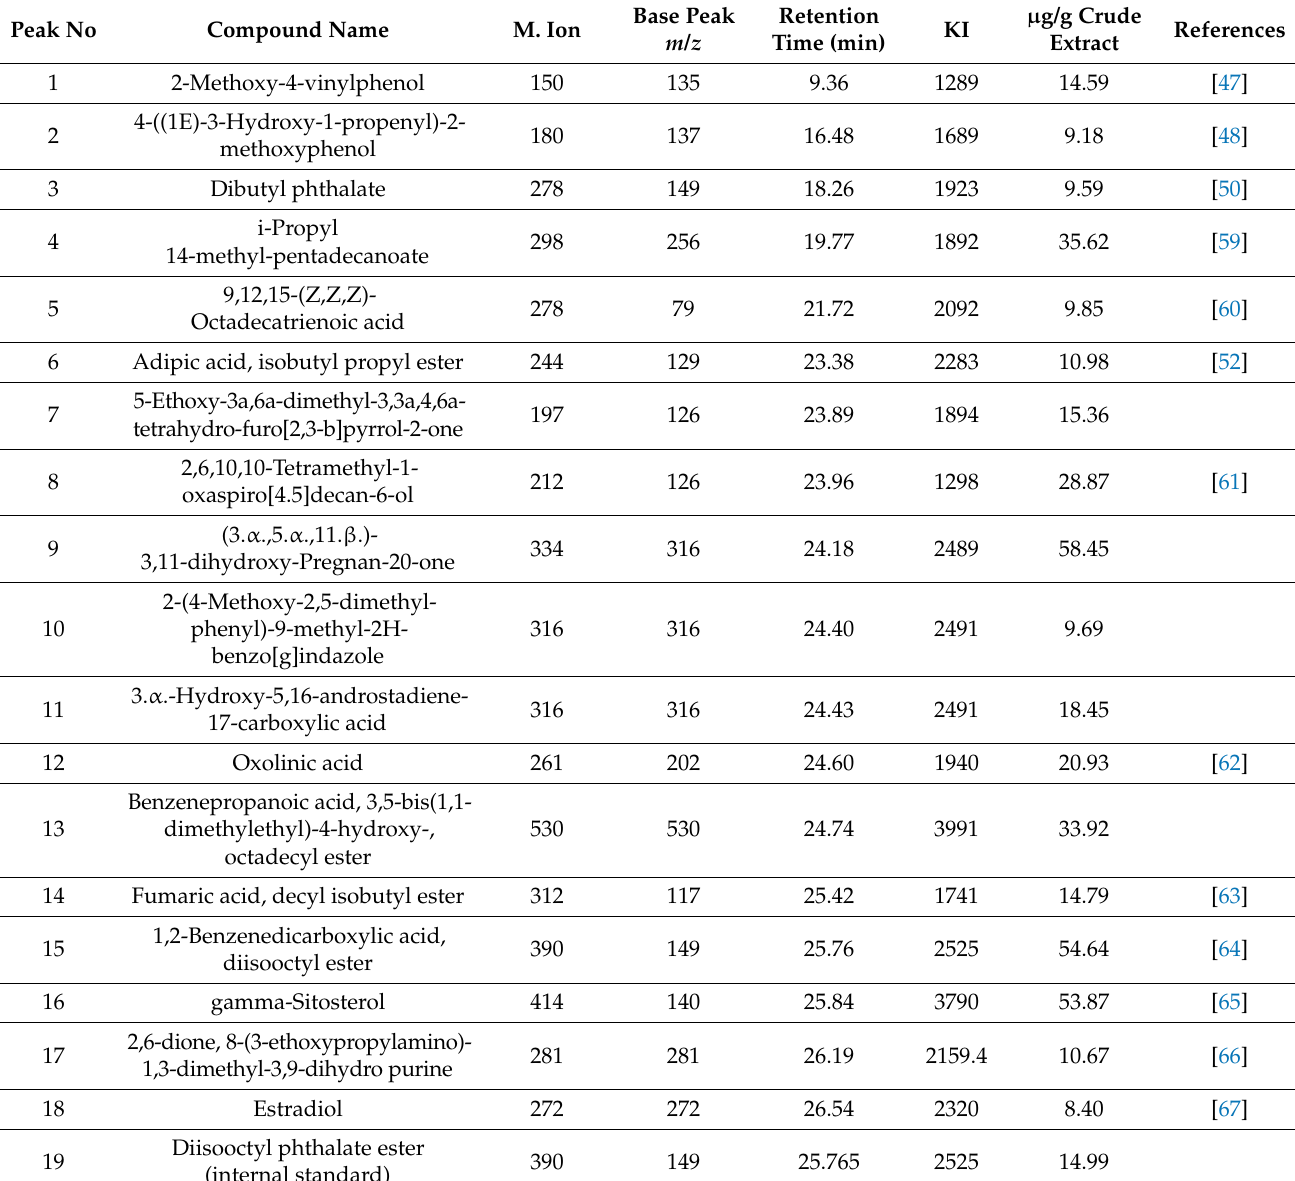
Table 7. Phytochemical compounds identified by GC-MS in methanolic extracts of immature (K I ) fruits of K. pinnata